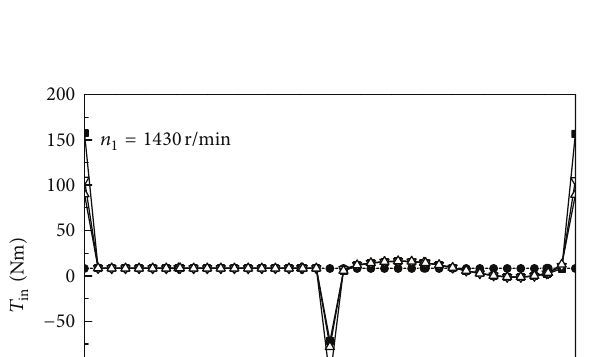
Figure 7: The diagram of the input torque.